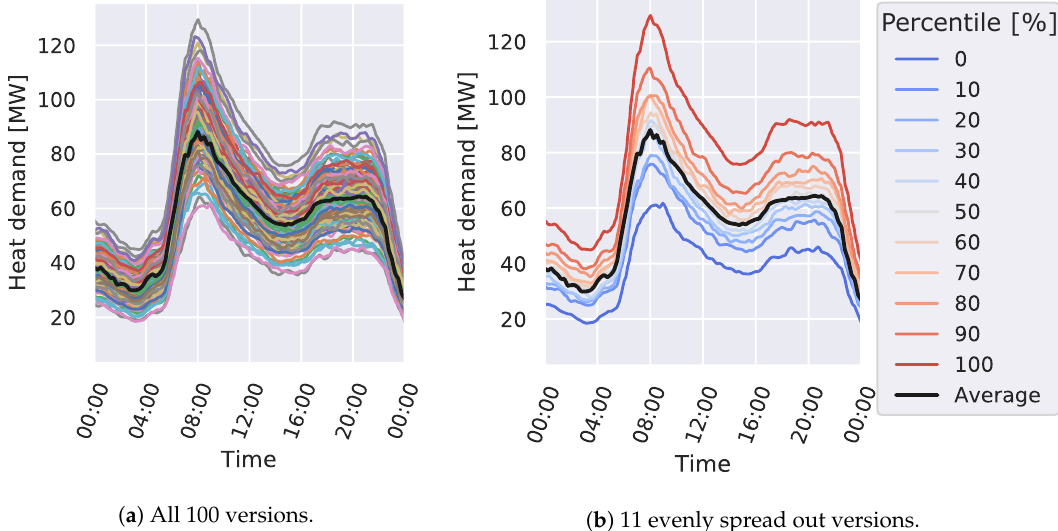
Figure 5. The different heat demand profiles of GenkNET for the Trans_Negp e day. The black line indicates the expected heat